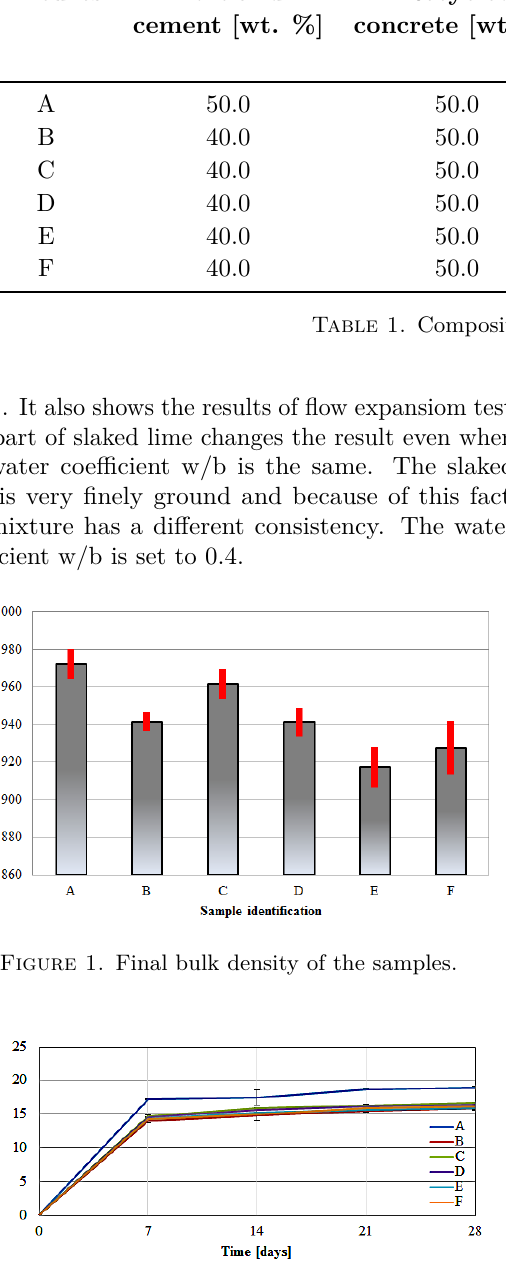
Figure 2. Development of the dynamic Young’s mod- ulus for the samples.